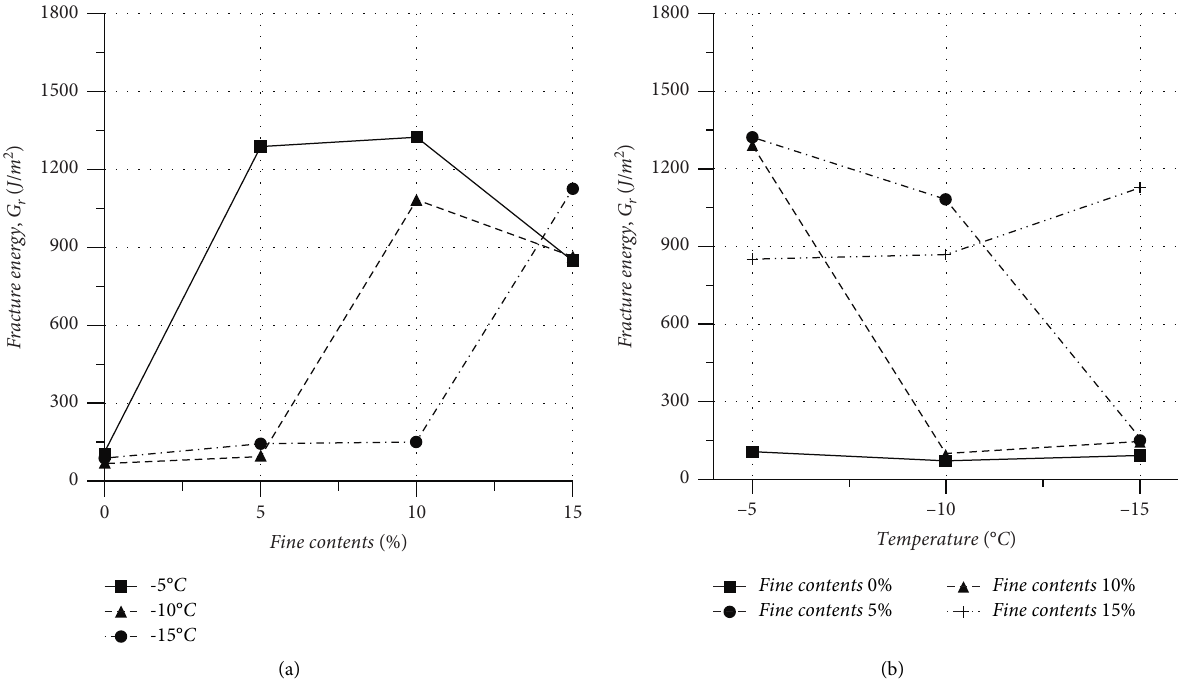
Figure 17: The fracture energy of the frozen sand specimen with 0, 5, 10, and 15% fine contents at − 5, − 10, and − 15 ° C. (a) Fracture energy versus fine contents. (b) Fracture energy versus